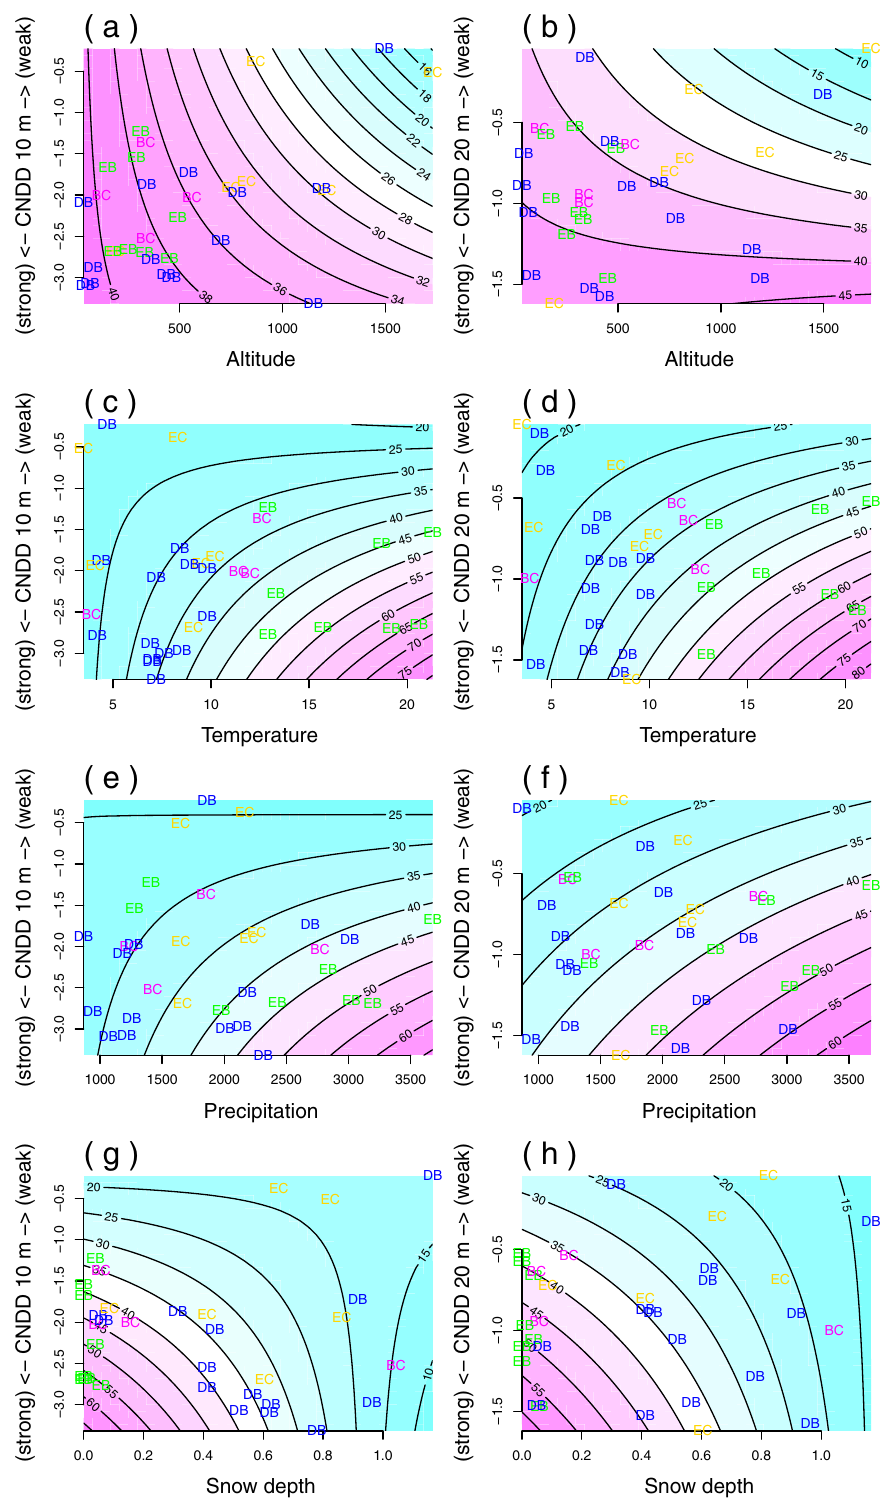
Figure 4. Contour plots from linear models explaining species number by CNDD in 10 m ( a , c , e , g ) and 20 m ( b , d , f , h ) spatial scale across environmental gradients of altitude, temperature, precipitation and snow depth. Contour lines and colours describe predicted species number. Observed values are shown by characters corresponding forest